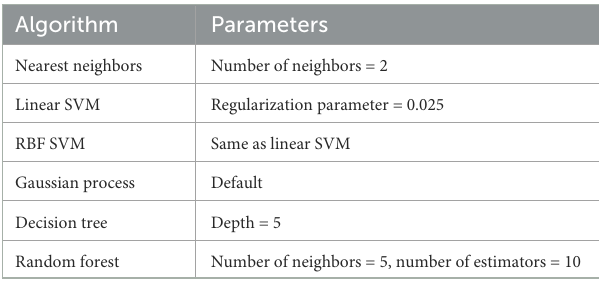
TABLE 1 Machine learning algorithms and their parameters.